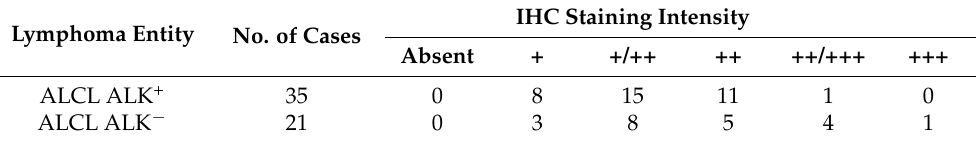
Table 1. Staining in ALK + and ALK −